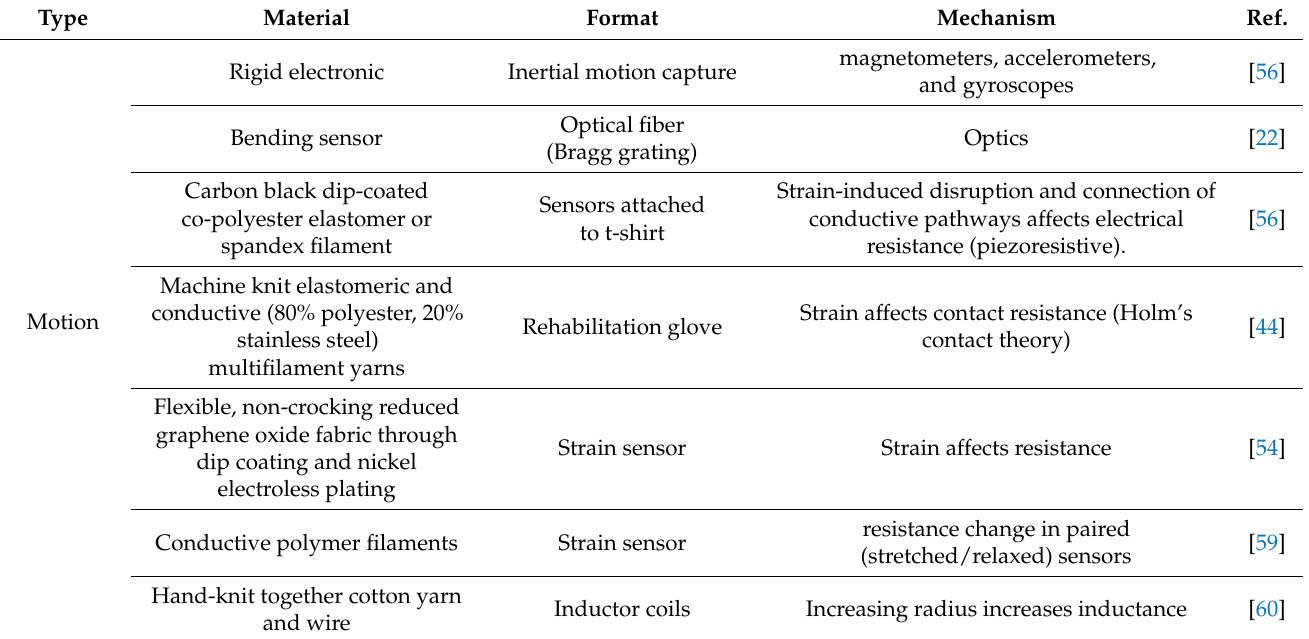
Table 2. Sensors used in electronic